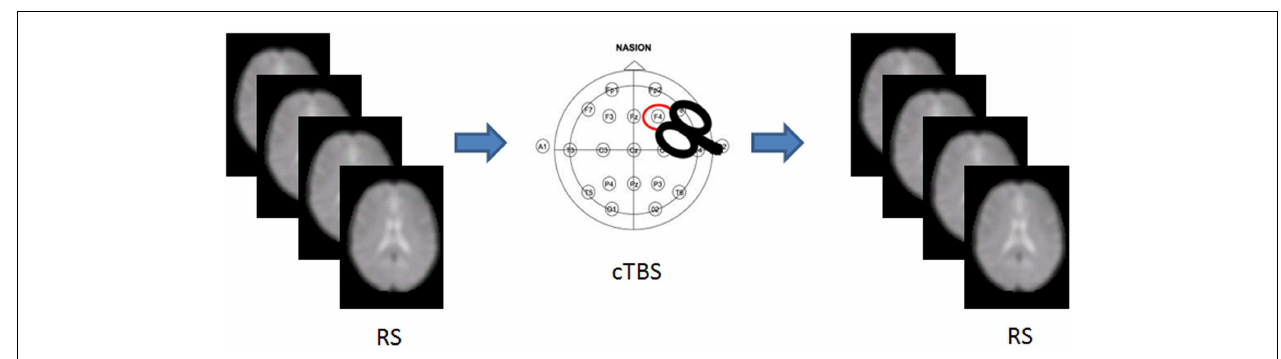
FIGURE 1 | Experimental set up . RS-fMRI was acquired before and after cTBS stimulation in half of the